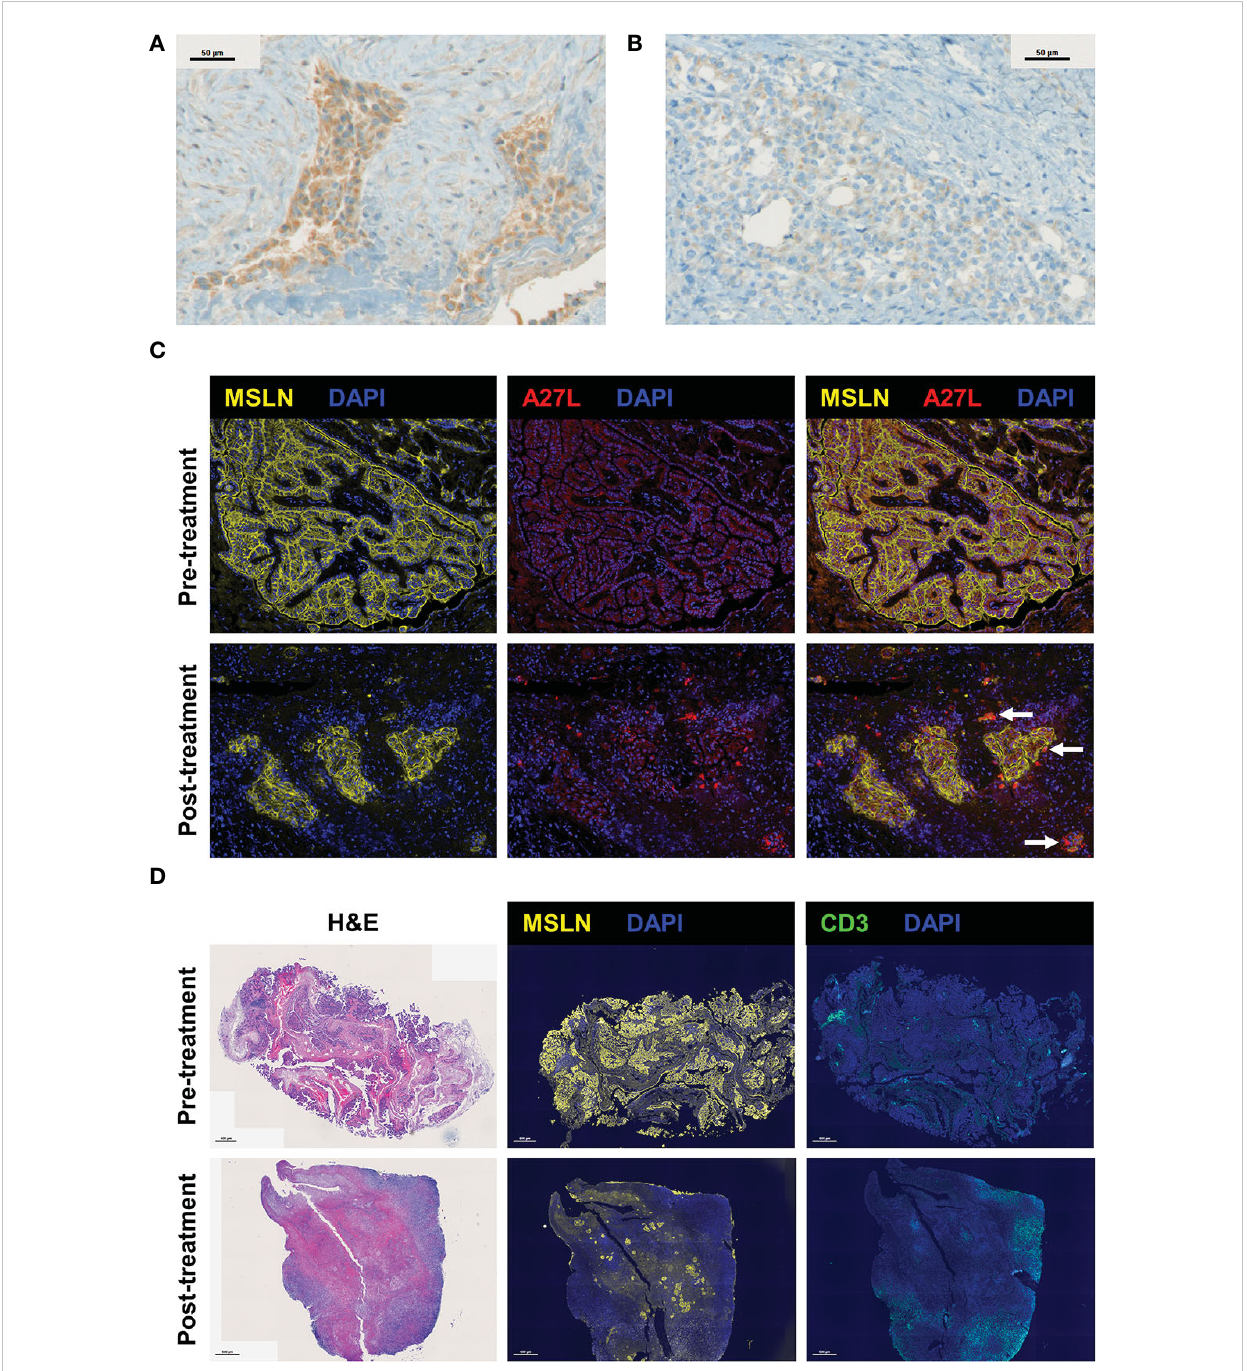
FIGURE 2 Visualization of Olvi-vec within tumor cells and the immune cell in fi ltrate in malignant pleural mesothelioma (MPM) tumors following Olvi-vec treatment. (A) Representative image of an immunohistochemistry (IHC)-stained section of a post-treatment tumor specimen from Patient #1 showing cytoplasmic positivity for Olvi-vec. (B) Representative image of an IHC-stained section from Patient #1 nine months later, showing weak/ absent Olvi-vec staining. (C) Representative multiplex immuno fl uorescence (mIF) images of pre- and post-treatment tumor specimens from Patient #16, stained with anti-mesothelin and A27L (anti-Olvi-vec) antibodies. Arrows indicate tumor cells with cytoplasmic positivity for Olvi-vec, which are observed in the post-treatment specimen but not the pre-treatment specimen. (D) Representative images of pre- and post-treatment tumor specimens from Patient #16 stained with hematoxylin and eosin (H&E) (left panel), anti-mesothelin (MSLN) antibody (middle panel), and anti-CD3 antibody (right panel) in three consecutive cut sections. In the post-treatment specimen compared to pre-treatment, the density of tumor cells positive for MSLN is observed to be lower, and the density of immune cells positive for CD3 is observed to be